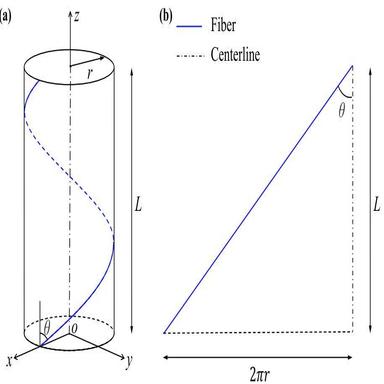
(a) Diagram of the coaxial helix geometric model; (b) Illustration of the helical fiber plane extension.